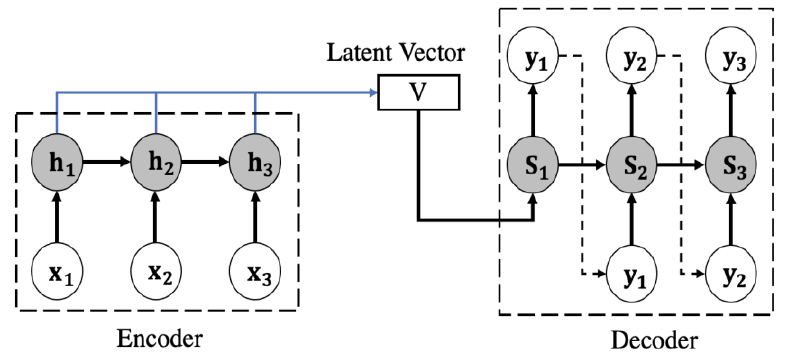
Figure 3. Structure of an encoder-decoder